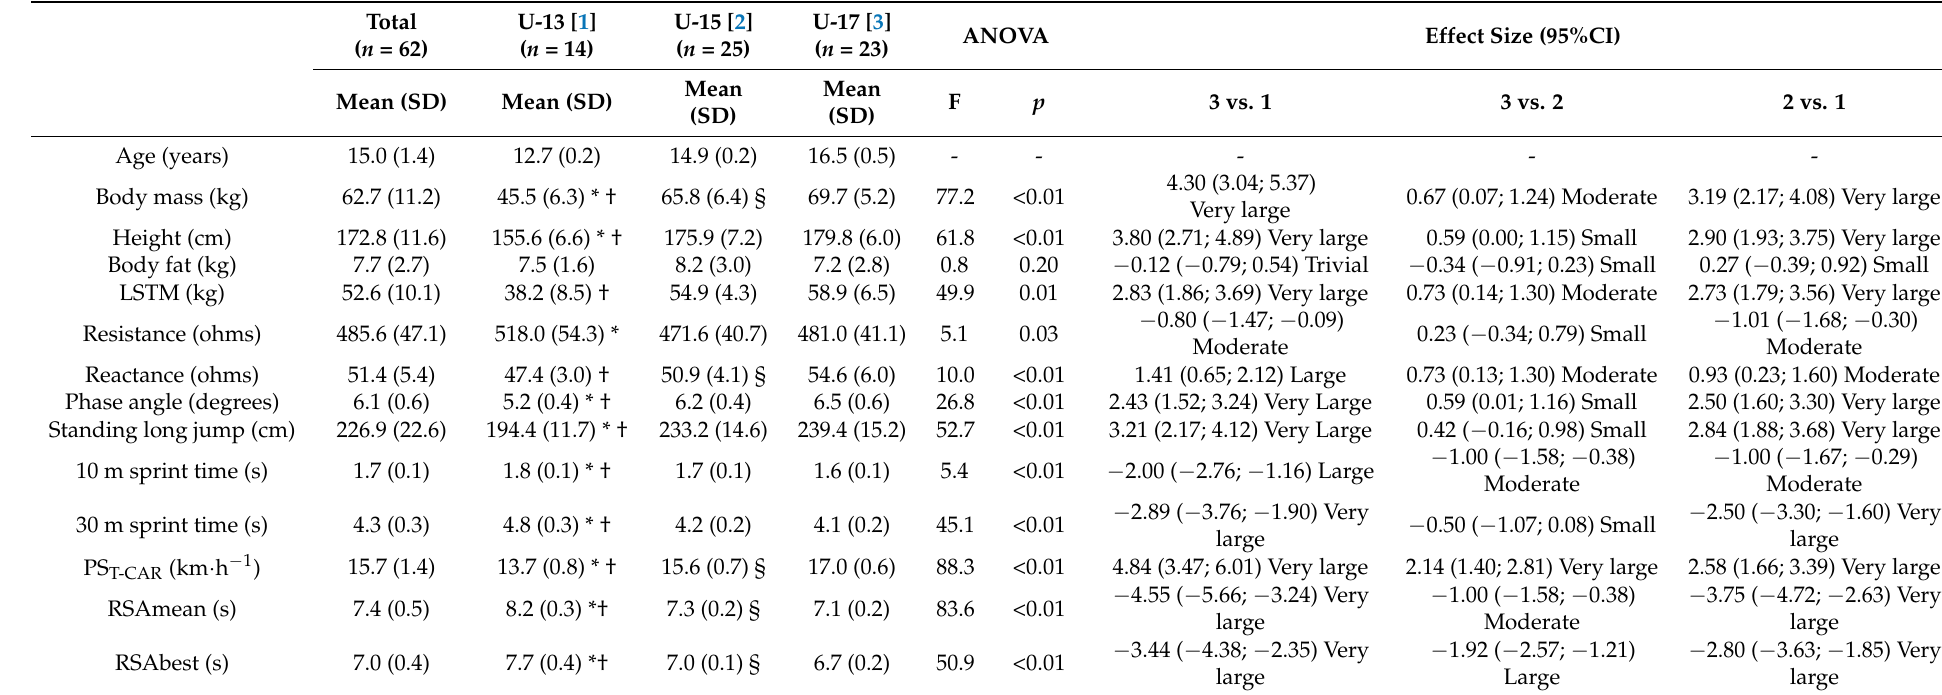
Table 1. Descriptive statistics (mean ± SD) for body composition and physical performance outcomes considering total sample ( n = 62) and age categories (U-13, U-15, and U-17) with ANOVA outputs and effect sizes (with 95% confidence